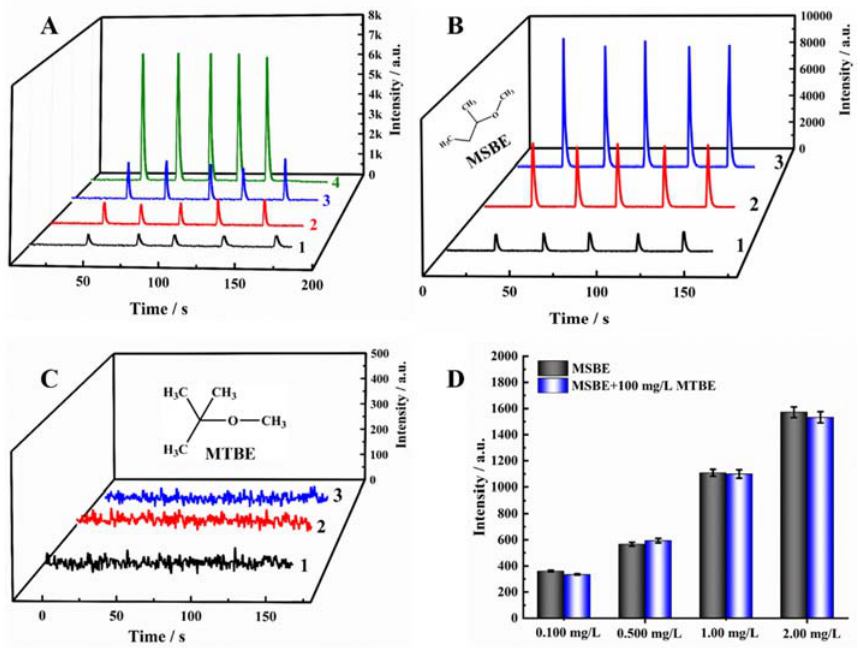
Figure 5. ( A ) CTL curves of 5.00 mg/L MSBE based on Co 3 O 4 (line 1), Au NPs@Co 3 O 4 (line 2), Pt NPs@Co 3 O 4 (line 3), and Pt/Au NPs@Co 3 O 4 (line 4); ( B ) CTL response of different concentrations